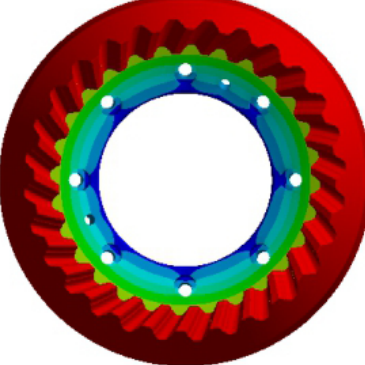
Figure 8. The 1st and 2nd order modes of bevel gear 1: torsional vibration.